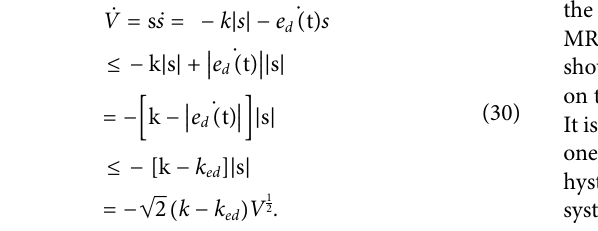
Frontiers in Materials |